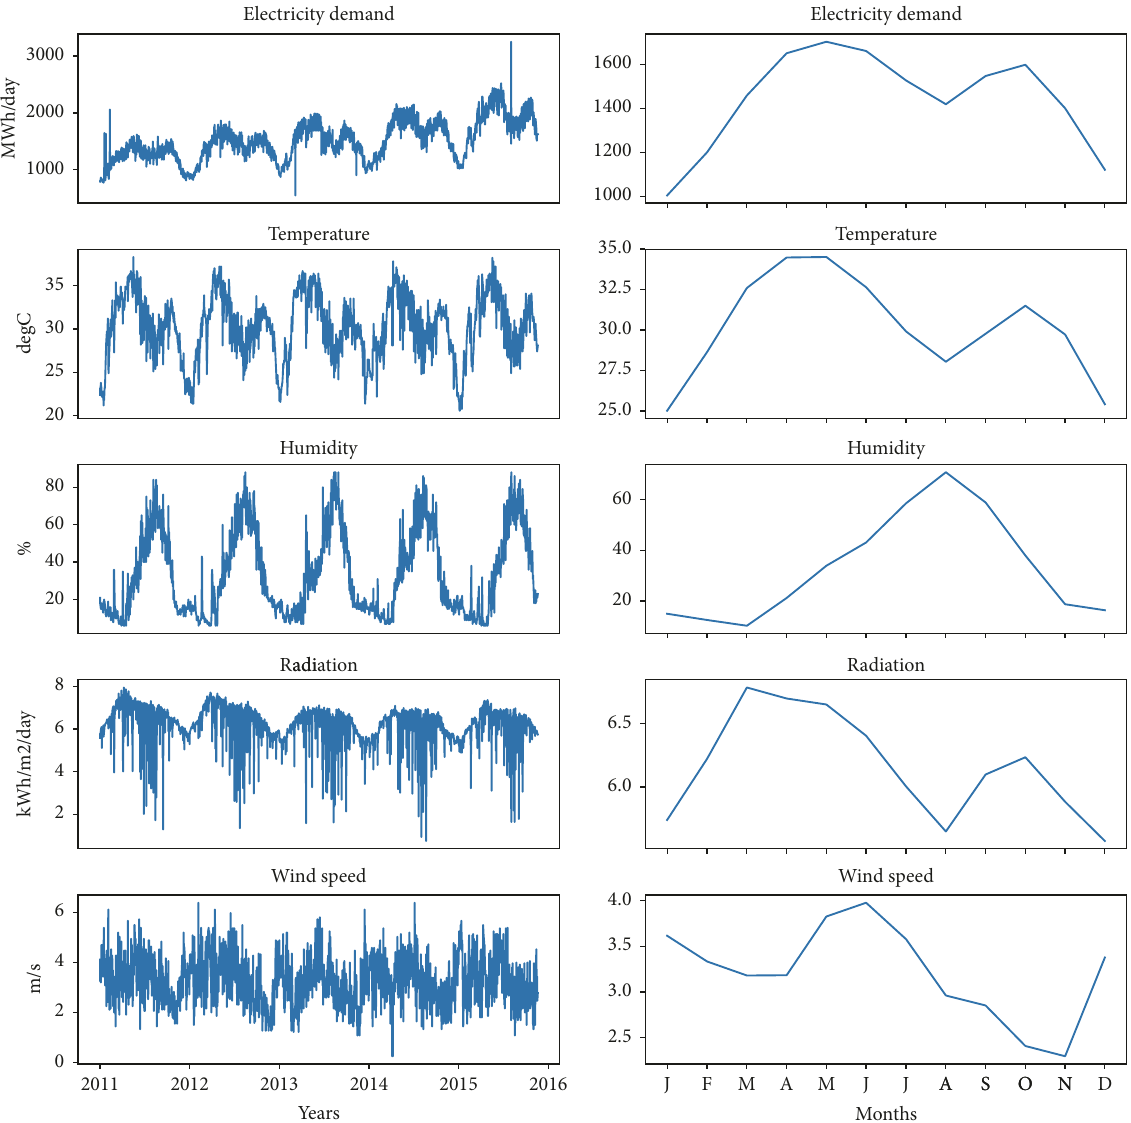
Figure 1: Time series plot (left panel) and monthly climatology (right panel) of electricity demand, air temperature, humidity, radiation, and wind